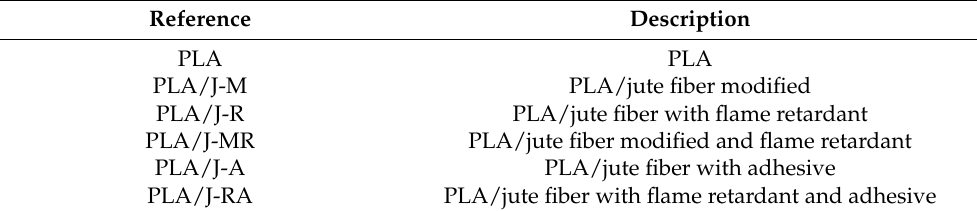
Table 1. Materials description and their reference used in this